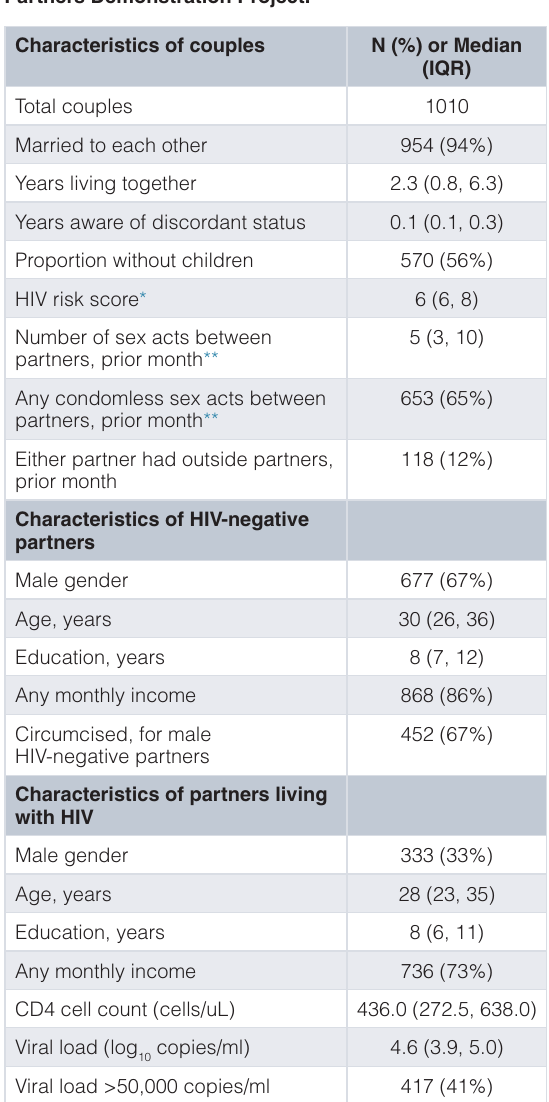
Table 1. Characteristics of couples enrolled in the Partners Demonstration